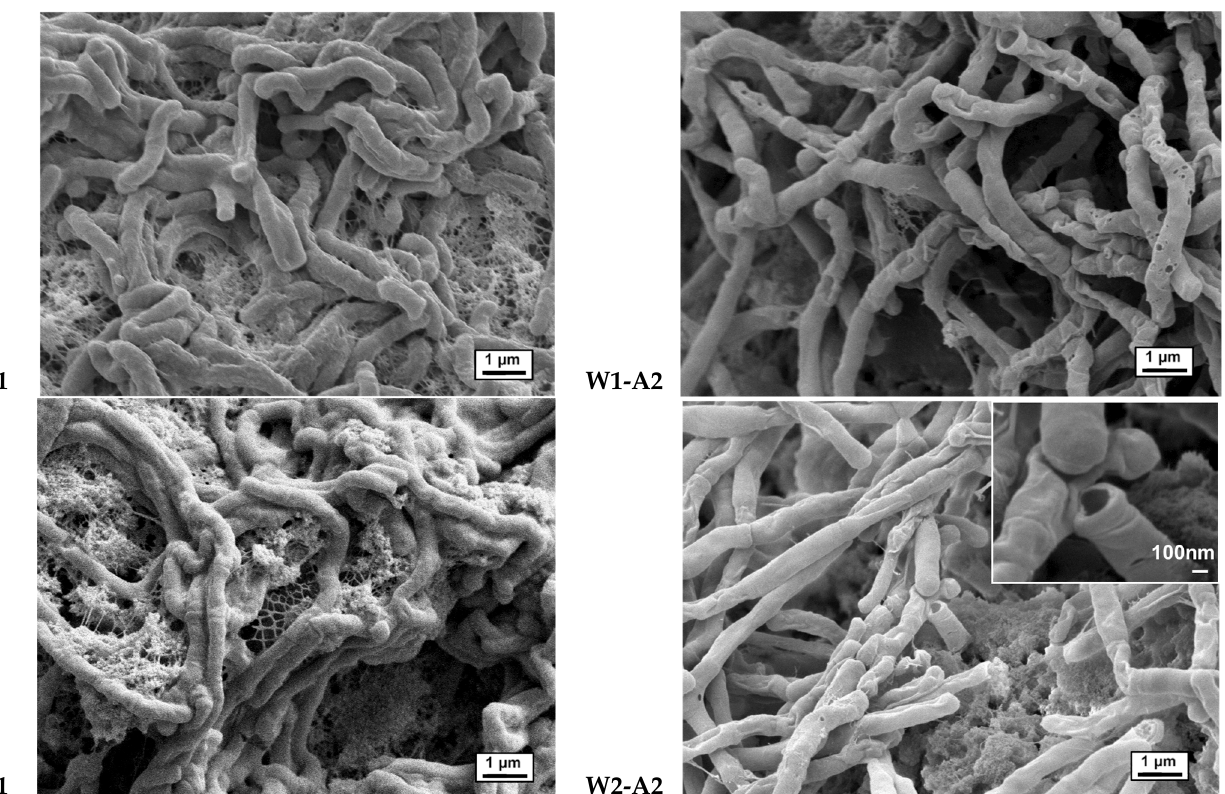
Figure 5. SEM images of worm-shaped microtubes after (left) the first amylase digestion W1-A1, W2-A1 and (right) second amylase digestion W1-A2 , W2-A2 . Scale bar, 1 μ m (inset for W2-A2 at higher magnification, scale bar 100 nm).